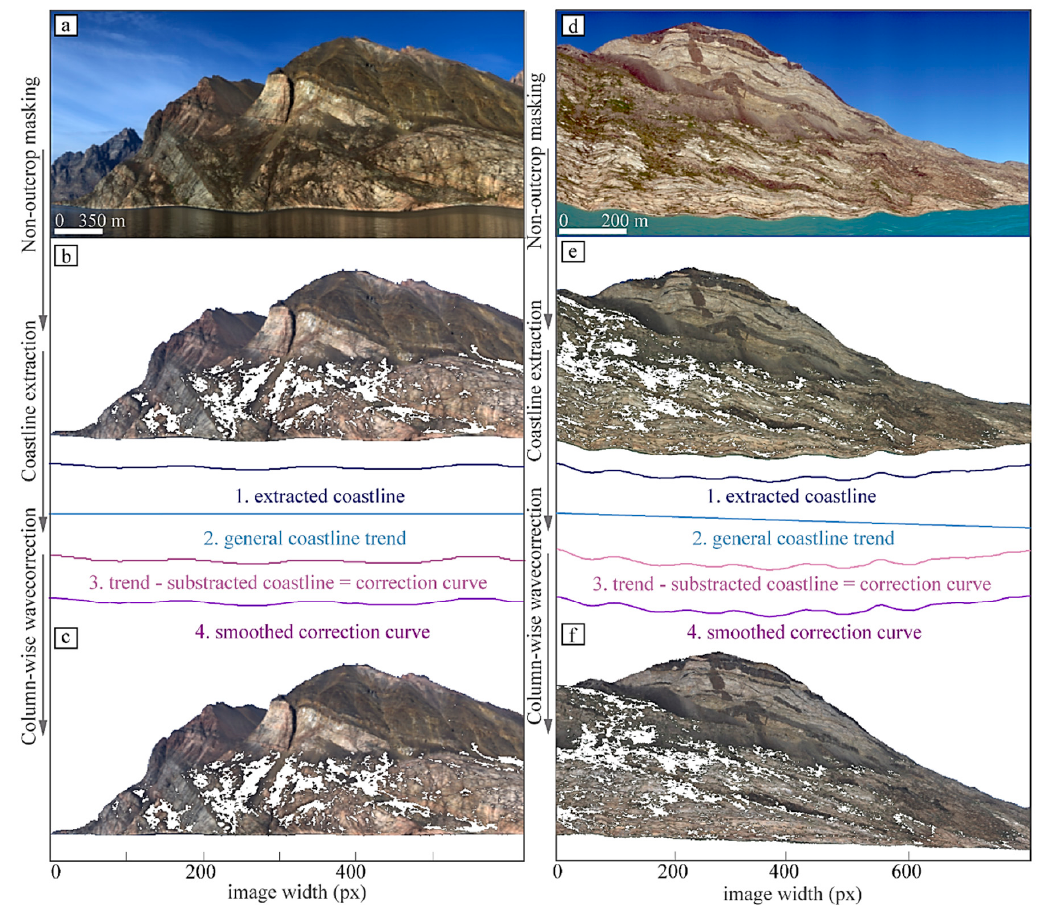
Figure 5. Schematic workflow to correct for wave-related image distortions for: Karrat ( a – c ) and Søndre Strømfjord ( d – f ). ( a , d ) Original reflectance images are displayed using spectral true color representative bands (R: 640 nm; G: 550 nm; and B: 470 nm), featuring distortion effects originating from the periodic movements of the vessel; ( b , e ) reflectance image after masking water, sky, vegetation and low albedo pixels (indicated by white pixels); and ( c , f ) resulting wave-corrected reflectance image. The amount of shift (4) to be applied for each image column is calculated by first subtracting the values of the general coastline trend (2) from the values of the extracted coastline (1) and afterwards applying a Savitzky–Golay filter for smoothing and removing outlier pixels .